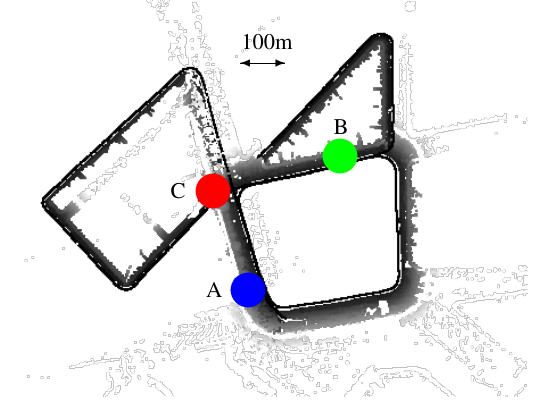
Figure 8: Registration results, colored with respect to the distance from the MMS. Three areas of interest (A,B,C) are detailed on Figure